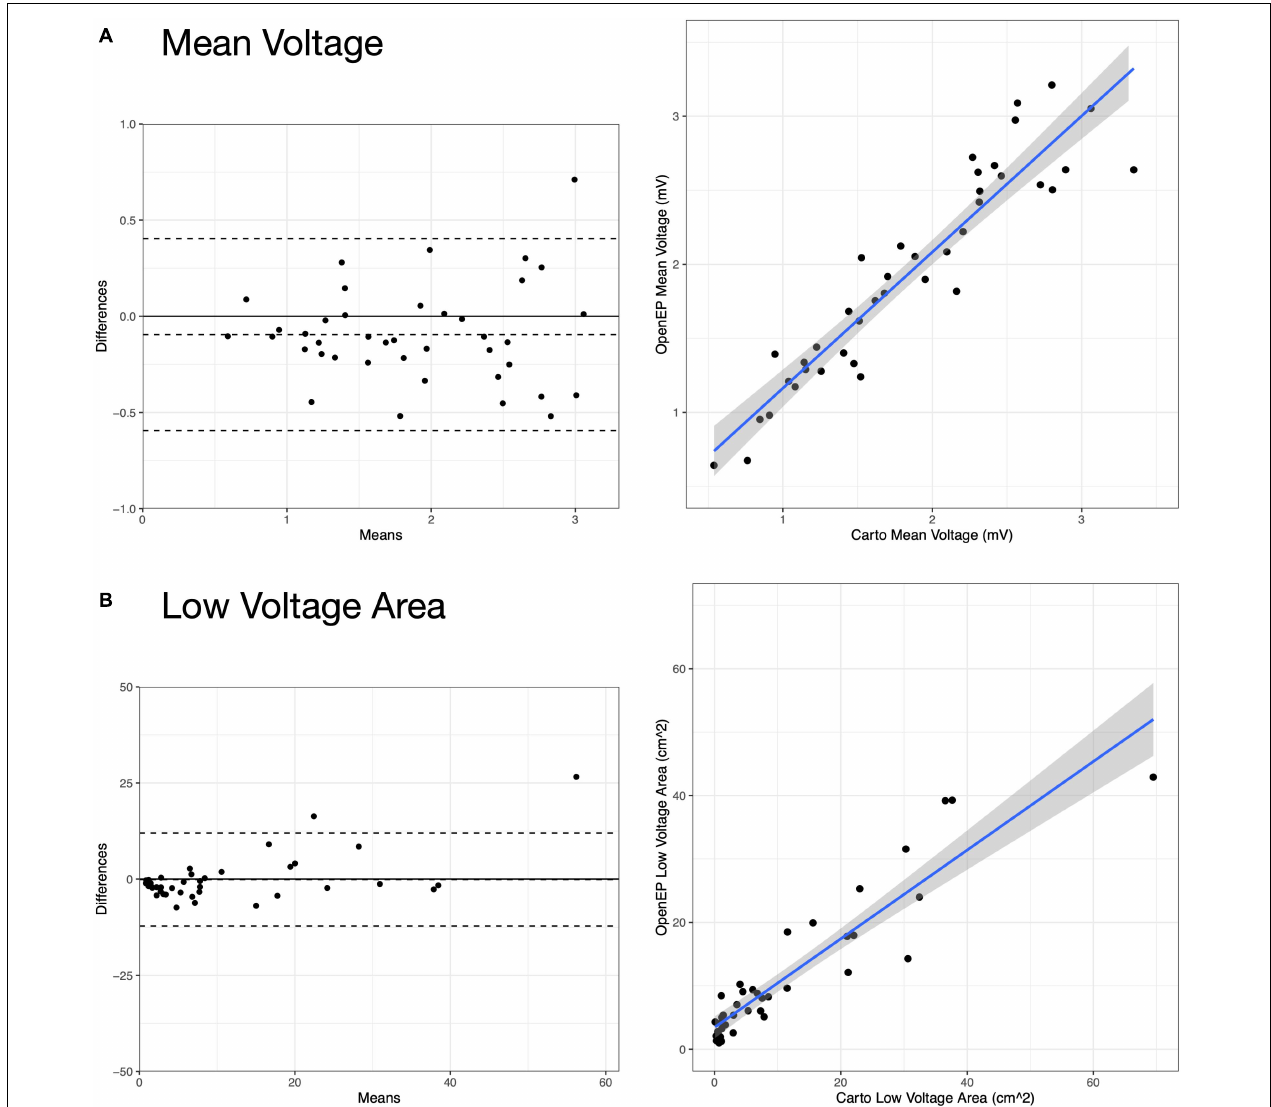
FIGURE 10 | Analysis of Carto and OpenEP voltage mapping data. (A) Assessment of mean chamber voltage using Carto and OpenEP. (B) Assessment of low voltage area using Carto and OpenEP. The OpenEP commands: getMeanVoltage(userdata, 'method', 'map'); getMeanVoltage(userdata, 'method', 'egm'); getLowVoltageArea(userdata, 'method', 'map') ; and getLowVoltageArea(userdata, 'method', 'egm') were used to create the data for these